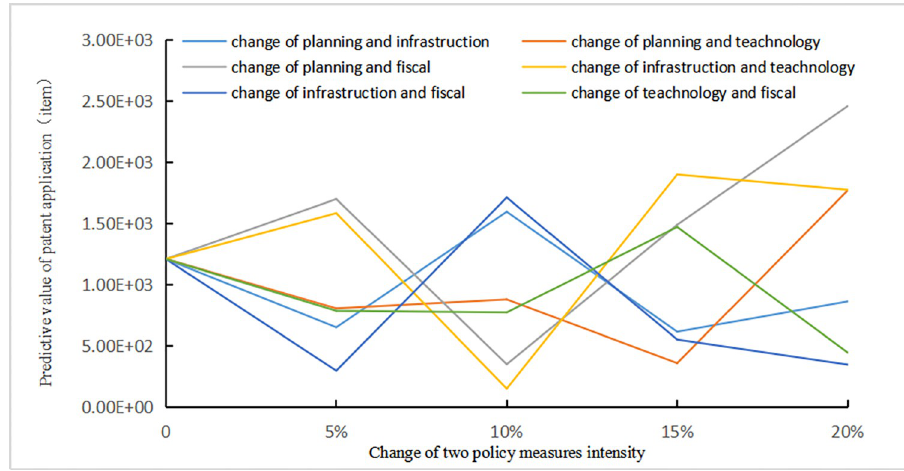
Fig 8. Relationship between intensity of two policy measures and number of patent